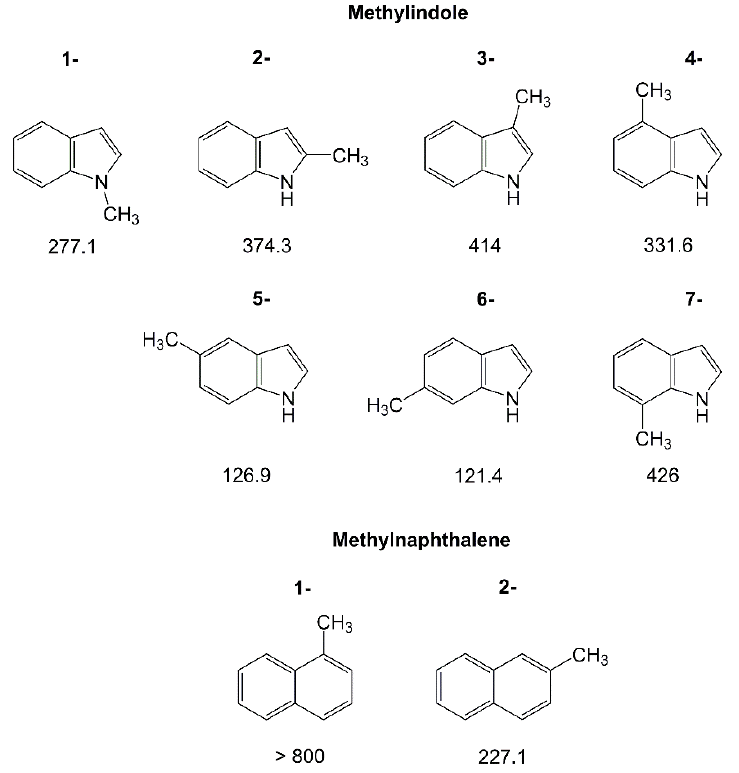
Figure 9. Barriers to methyl internal rotation in large aromatic rings (in cm − 1 ). ( 1 ) 1-Methylindole [188], ( 2 ) 2-methylindole [188], ( 3 ) 3-methylindole [188], ( 4 ) 4-methylindole [188], ( 5 ) 5-methylindole [188], ( 6 ) 6-methylindole [188], ( 7 ) 7-methylindole [188], ( 8 ) 1-methylnaphthalene [131], ( 9 ) 2-methylnaphthalene [131].